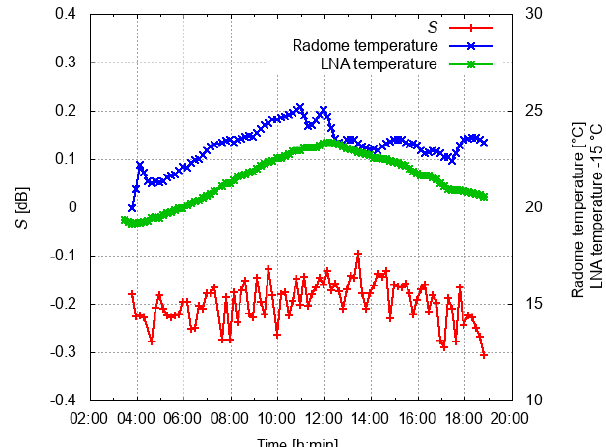
Figure 7. Variability in differential solar power S (dB) on 3 June 2018 (UTC). Also shown is the radome temperature and the temperature near the LNA in the receiver box.